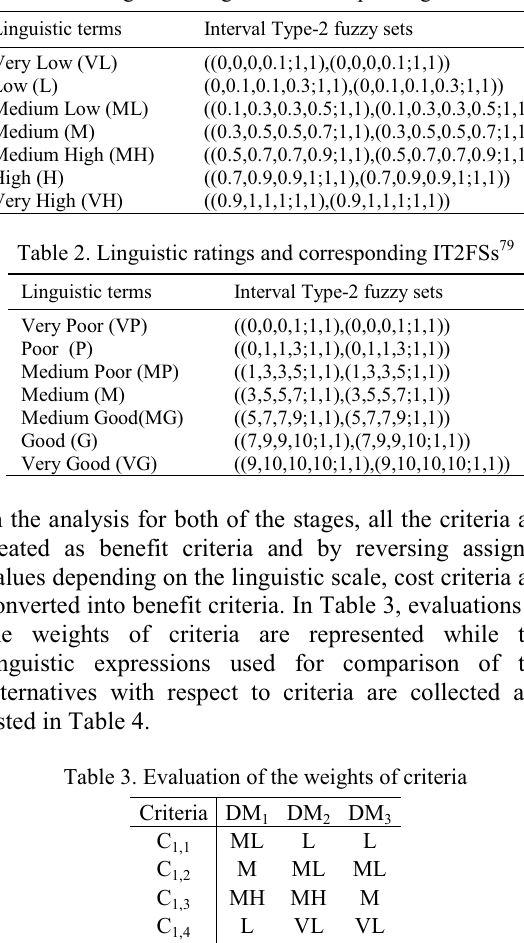
Table 1. Linguistic weights and corresponding IT2FSs 79